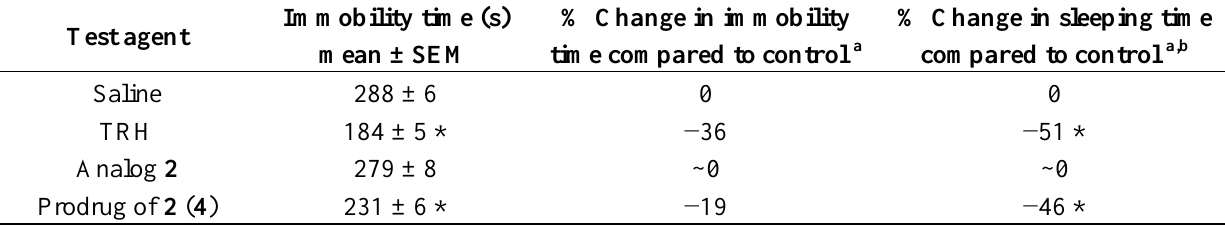
Table 1. Porsolt’s swim test (PST) immobility times reflecting the antidepressant-like effect of the TRH analog 2 with or without utilizing its bioprecursor prodrug 4 . TRH was used as a positive control. Test compounds were administered i.v. at the dose of 3 µmol/kg body weight. * p < 0.05 versus saline vehicle control (ANOVA followed by Dunnett’s